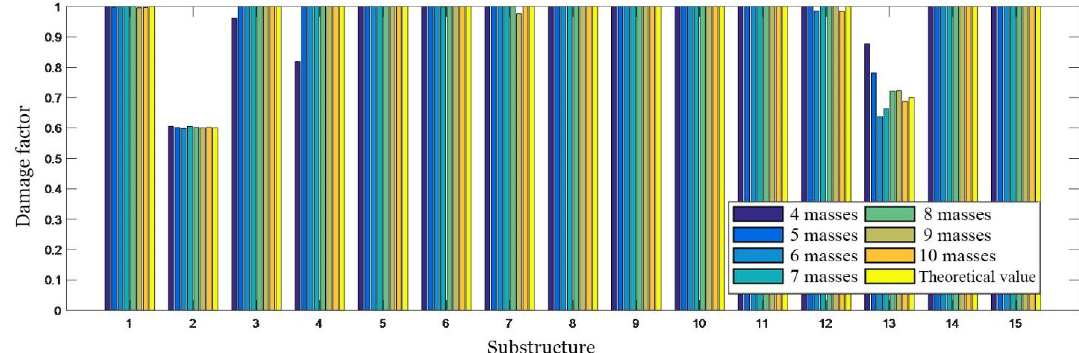
Figure 14. Damage identification results obtained by employing different numbers of masses.